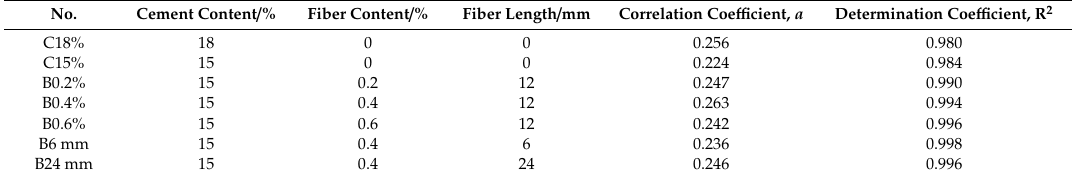
Table 8. Fitting results of the relationship between tensile strength and compressive strength.